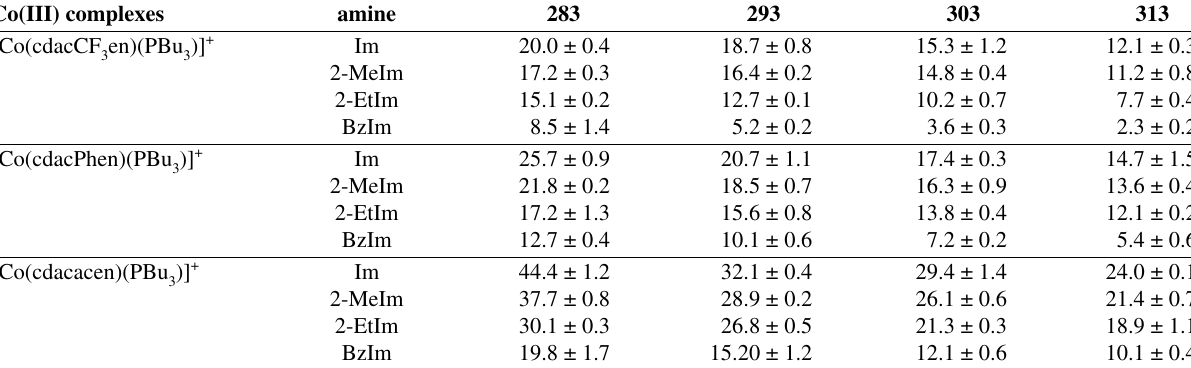
Table 2. The formation constants, (10 –2 × K ture (K). Co(III) complexes